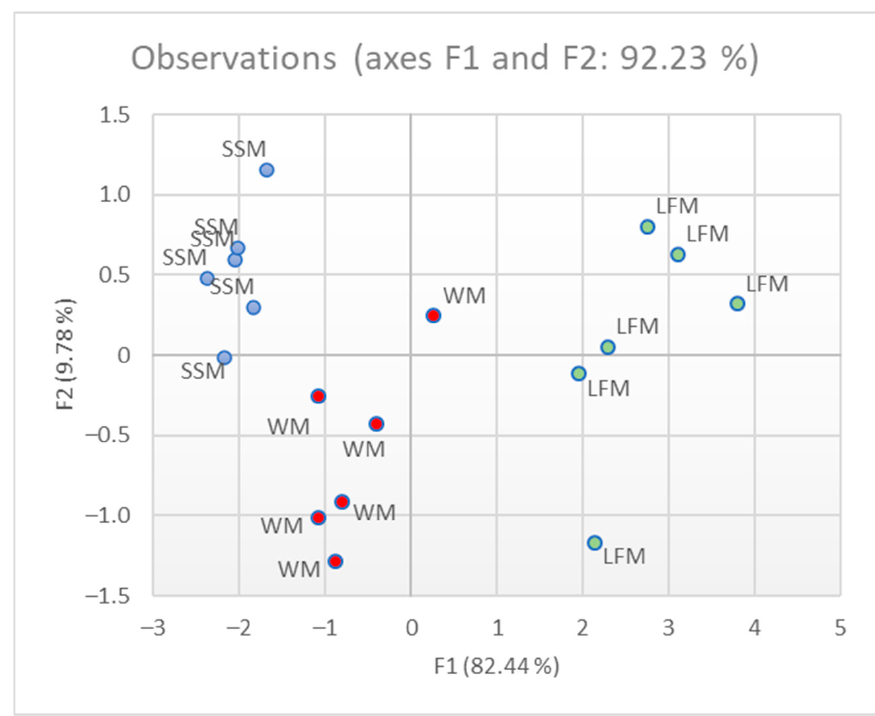
Figure 9. PCA analysis to distinguish whole milk (WM, red dots), semi-skimmed milk (SSM, blue dots) and lactose-free milk (LFM, green dots) within brand 3. The PCA has been performed starting from the three variables C , R and Q .